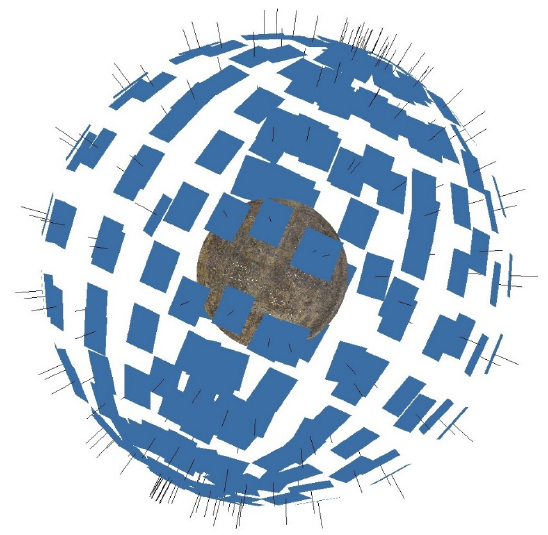
Figure 7. Image configuration. Source: author, Agisoft.